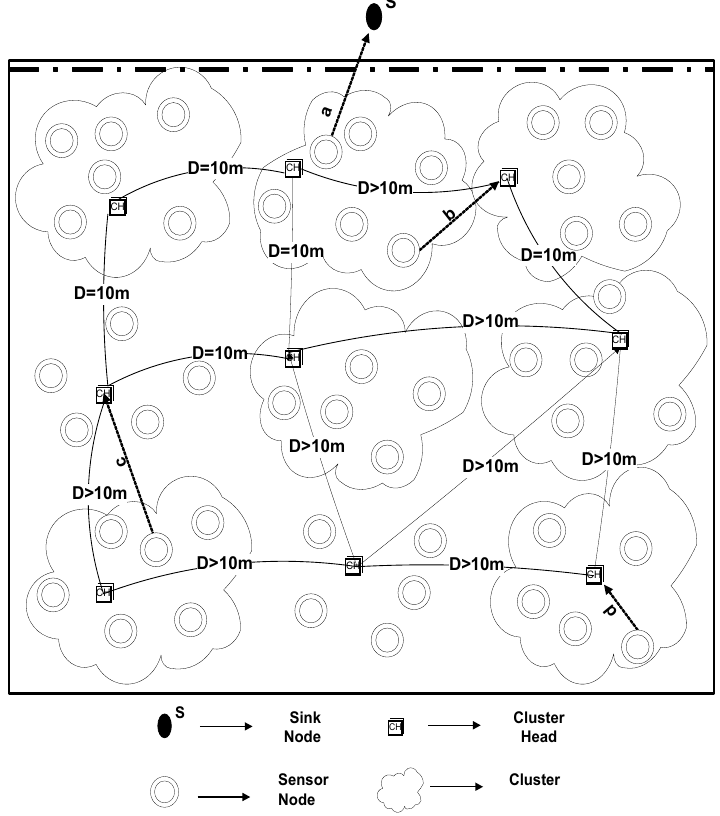
Figure 3. U-(ACH) 2 with One Sink at Water